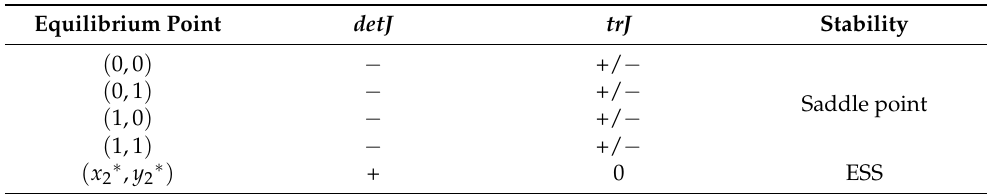
Table 6. Stability analysis of equilibrium points under dynamic reward and static punishment